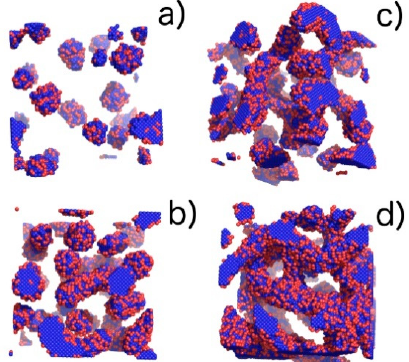
Figure 5. Visualization of phases with the increasing volume fraction ( φ ) of the copolymer obtained from computer simulations: ( a ) pure micellar phase (M), φ = 0.04, T* = 3.0; ( b ) elongated rod-like micelles (M/R), φ = 0.1, T* = 1.3; ( c ) transition between elongated rod-like micelles and threedimensional Y-channels (R/CH), φ = 0.14, T* = 2.16; and ( d ) pure three-dimensional Y-channels (CH), φ = 0.2, T* = 2.16. Blue colour denotes A-blocks (tails and spacers) while red refer to B-blocks (gemini heads).